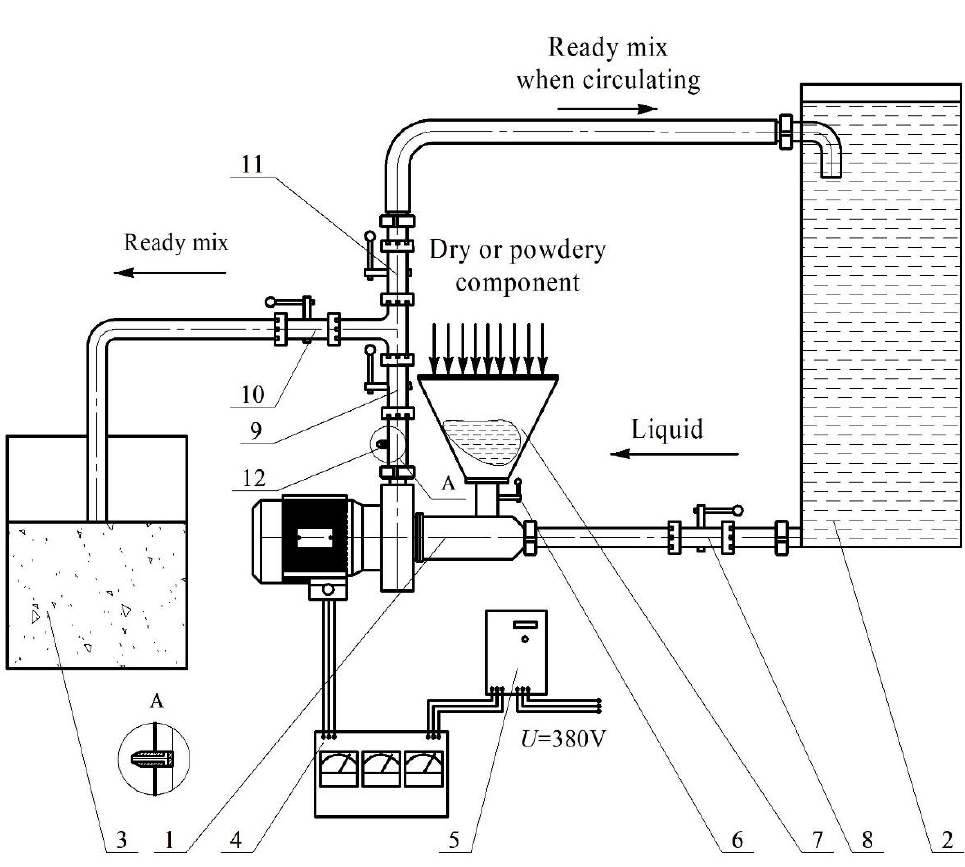
Figure 7. Scheme of operation of the installation with an open circuit. 1—installation; 2—water tank; 3—a tank with a ready-made mixture; 4—DMK-20 multimeter; 5—frequency converter; 6—component loading valve; 7—loading chamber; 8–12—ball valves